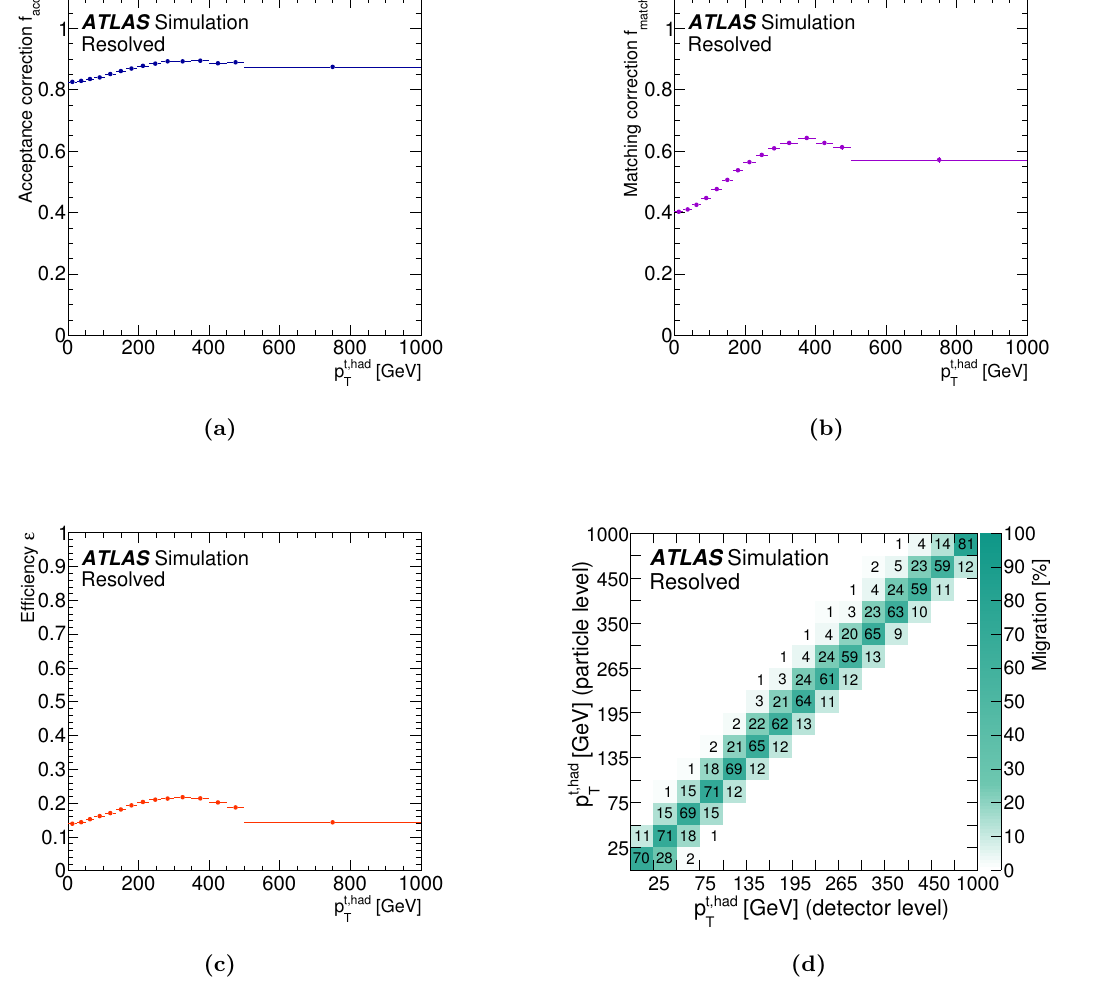
Figure 8. The (a) acceptance and (b) matching corrections, (c) e(cid:14)ciency, and the (d) particle-to- detector-level migration matrix for the hadronic top-quark transverse momentum in the resolved topology evaluated with the Powheg + Pythia6 simulation sample with h damp = m t and using CT10 PDF. In (cid:12)gure (d), the empty bins either contain no events or the fraction of events is less than 0.5%. Following section 8, the acceptance and matching corrections are binned according to detector-level quantities, while the e(cid:14)ciency is binned according to particle-level